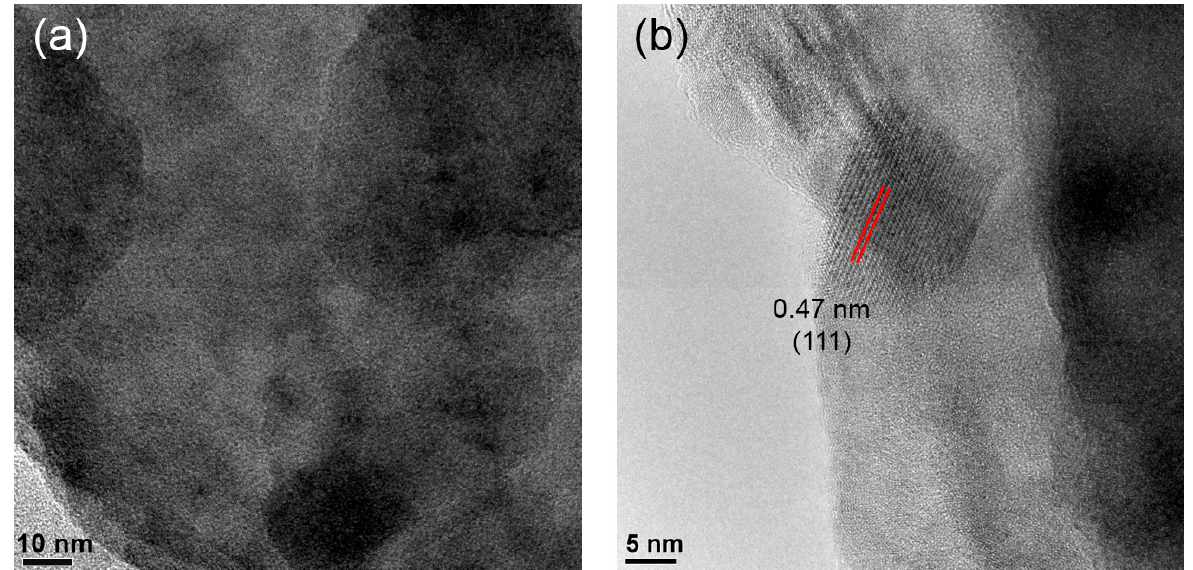
Figure 5. ( a , b ) HRTEM images of zone B in different areas. Red lines highlight the interplanar distance.